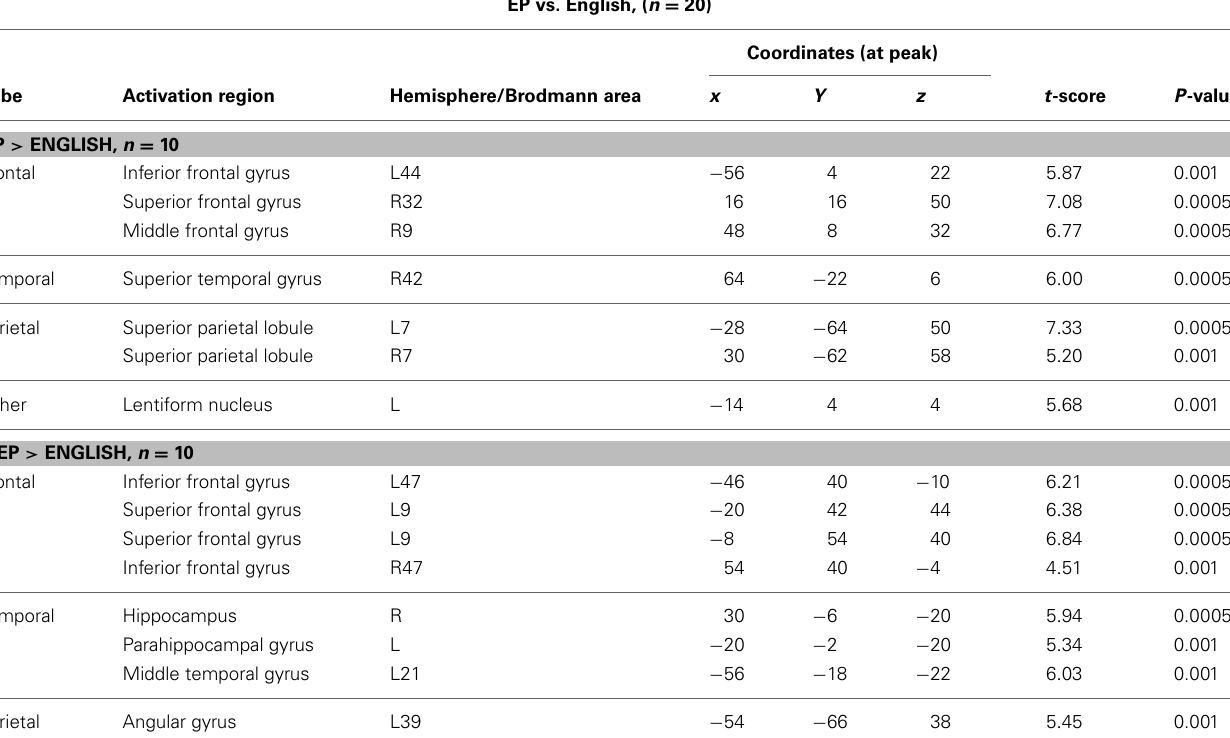
Table 3 | Univariate data: EP and